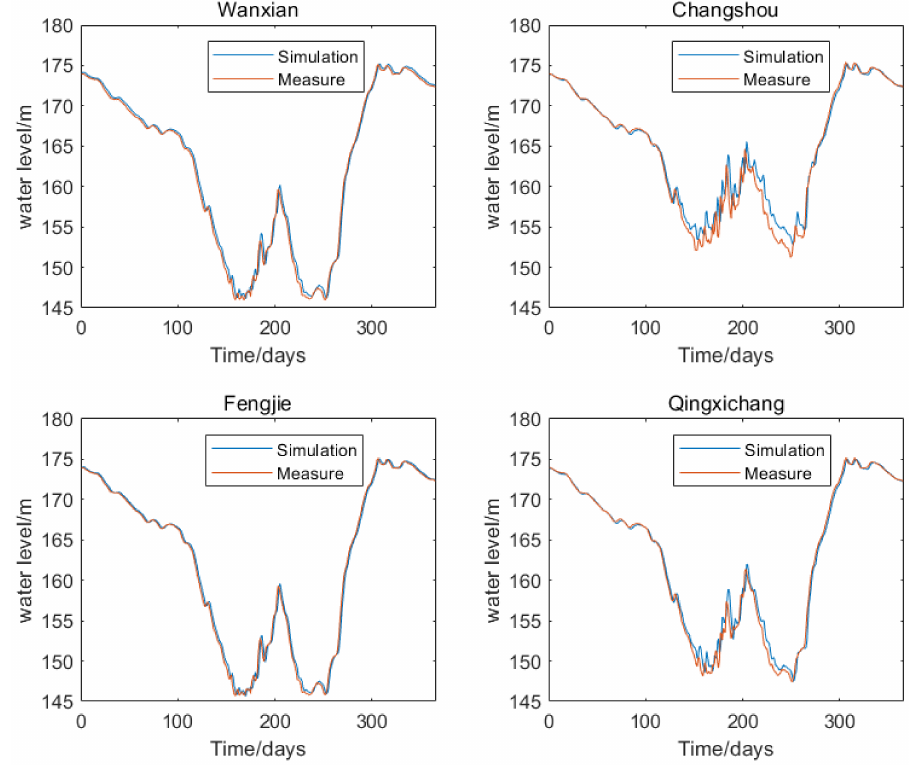
Figure 6. Comparison of the results from the simulation with measured data from 2016.